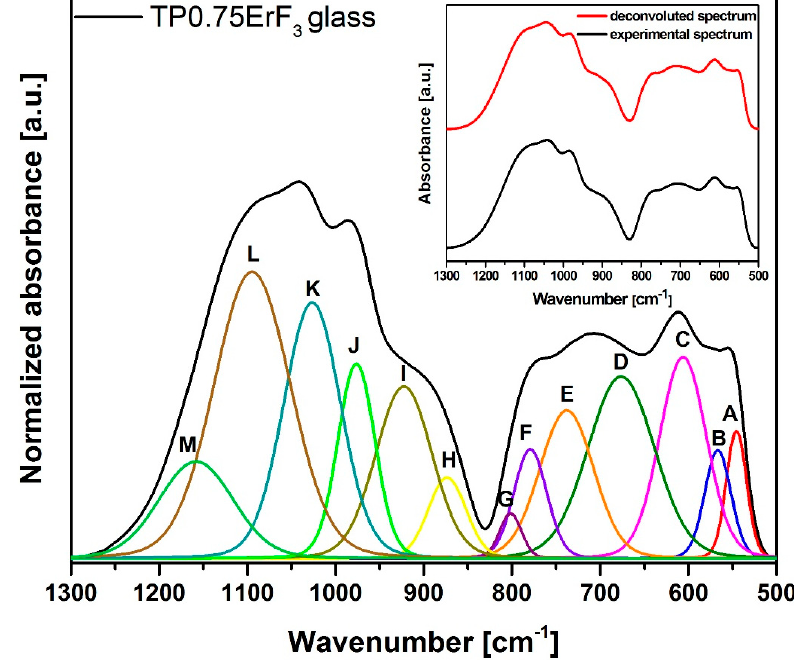
Figure5. DeconvolutedFTIRspectraofTP0.75ErF 3 glass. Figure 5. Deconvoluted FTIR spectra of TP0.75ErF 3 glass. (inset) Deconvoluted and experimental spectra.